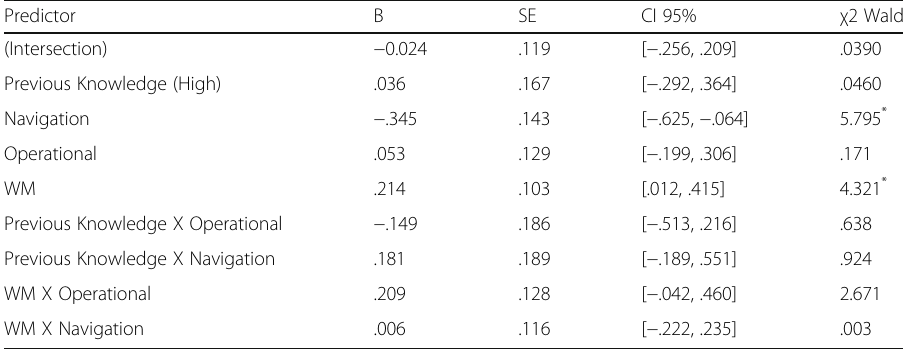
Table 5 Generalized linear regression of previous knowledge, working memory and Internet skills on comprehension Predictor B SE